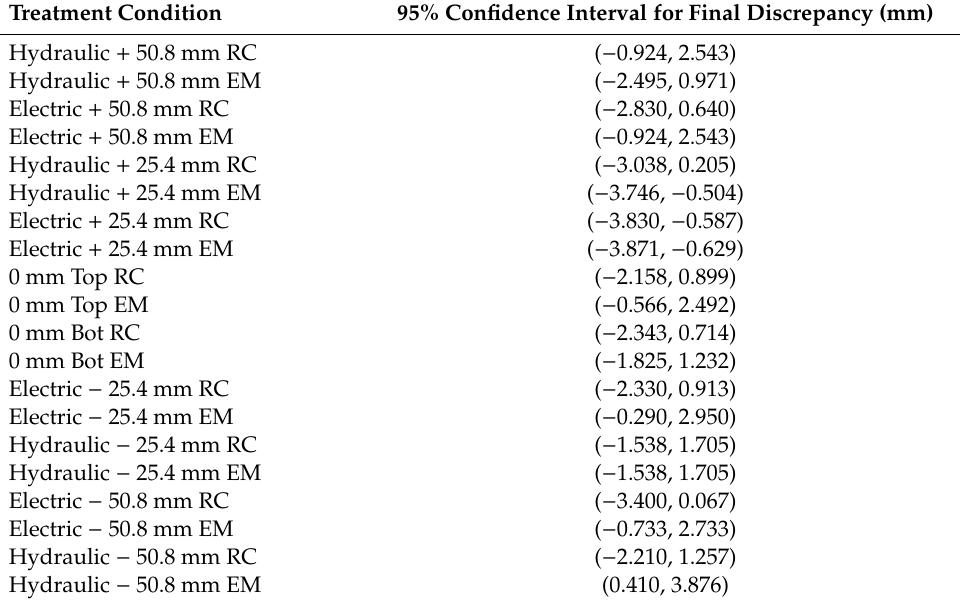
Table 5. 95% confidence intervals for final discrepancy (mm) for each of the treatment conditions and